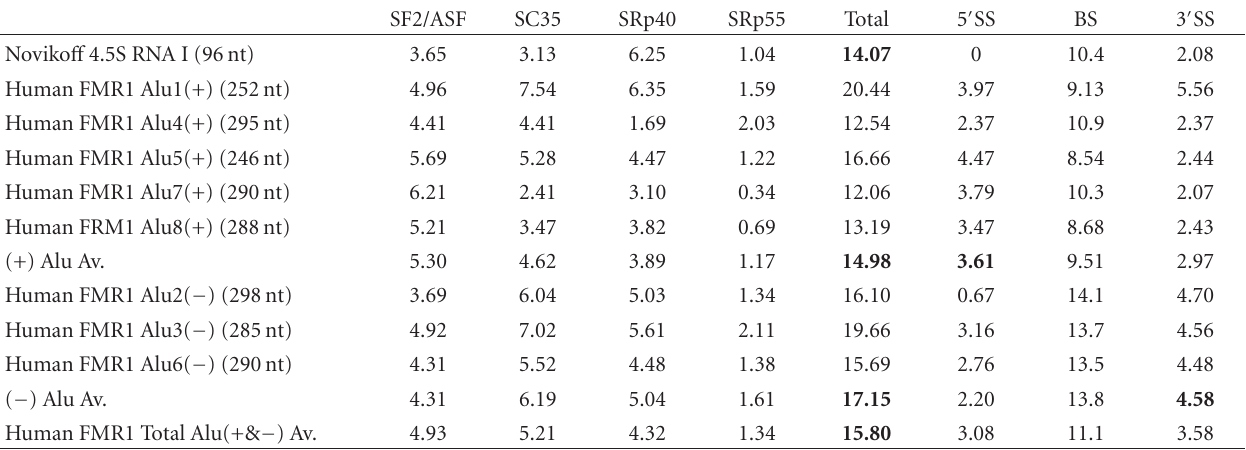
Table 8: Distribution of ESE, 5 (cid:2) splice sites, branch sites, and 3 (cid:2) splice sites. The ESE, 5 (cid:2) splice site, branch site, and 3 (cid:2) splice site in 4.5S RNA I and Alu elements in FMR1 gene transcript are screened by ESE finder (version 3) [13]. For this comparison, the number of motifs is calculated per 100 nucleotides. The motif patterns in Alu elements are all very much alike and the 4.5S RNA I resembles them. A di ff erence is found in that 5 (cid:2) splice sites in (+) Alu are more than in ( − ) Alu and 3 (cid:2) splice sits are more in ( − ) Alu than in (+)